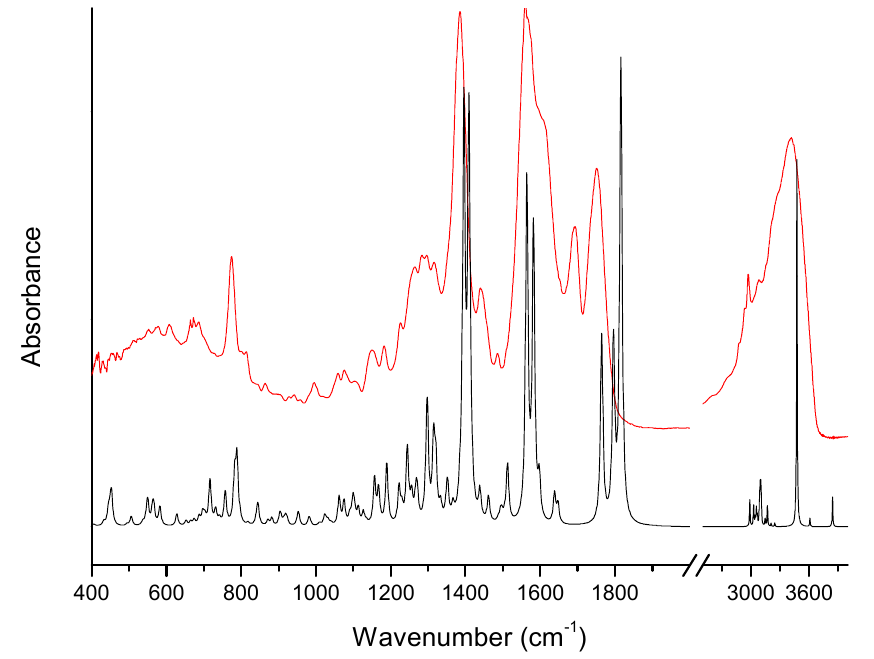
Figure 1. Calculated (black-DFT) and experimental (red) IR absorption spectra of ertapenem at room temperature.